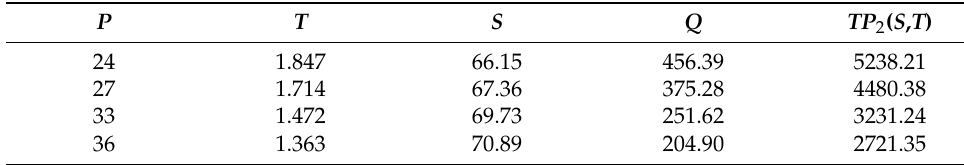
Table 5. Impact of purchasing cost ( P ) .